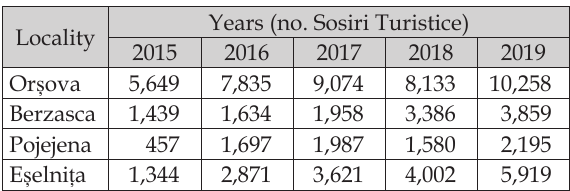
Table 4. The localities in the Danube Gorge where tourist arrivals